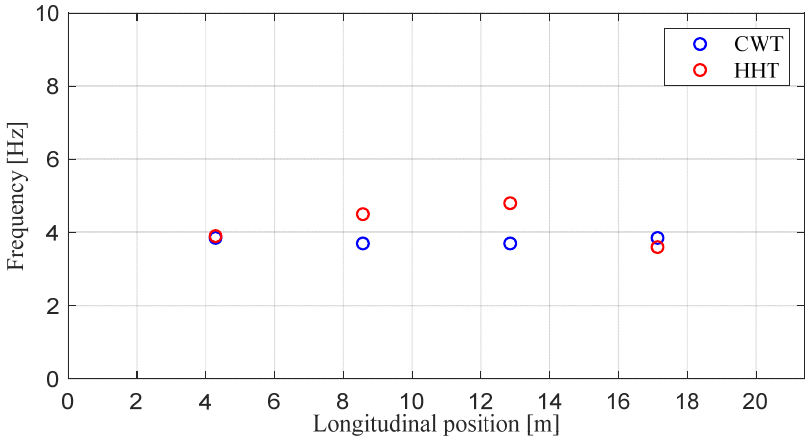
Figure 17. Damage-related frequency identified by HHT and CWT, respectively, as a function of damage position, in the case of severe damage affecting the cross-girder connection.